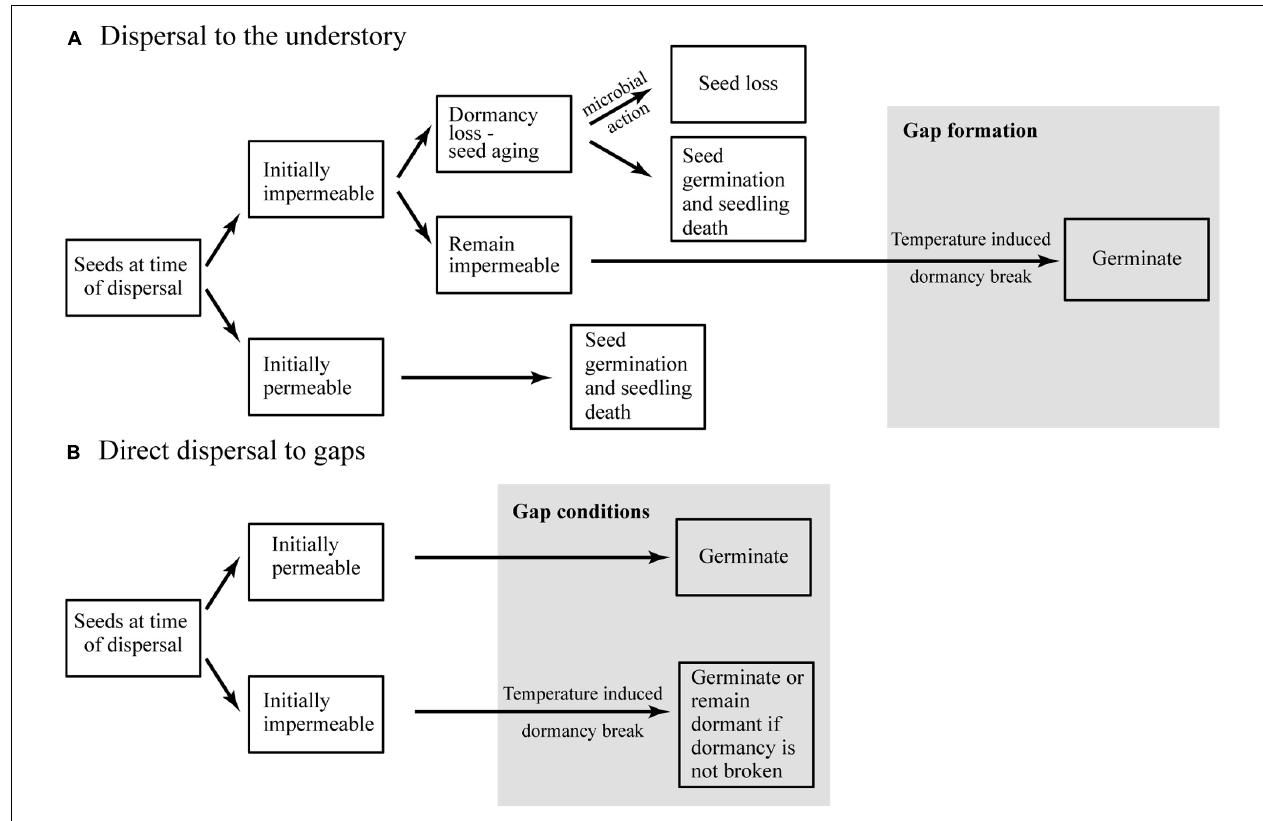
FIGURE 8 | Conceptual model summarizing seed persistence and germination in tropical forest species with physically dormant seeds dispersed to (A) the understory or (B) gaps.